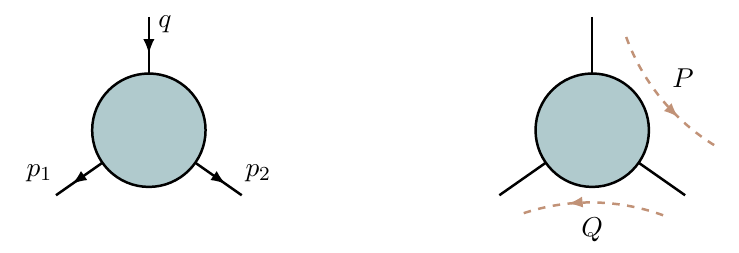
Figure 1 . External momenta assignment for auxiliary and symmetric point integrals(left) and for the large momentum expansion